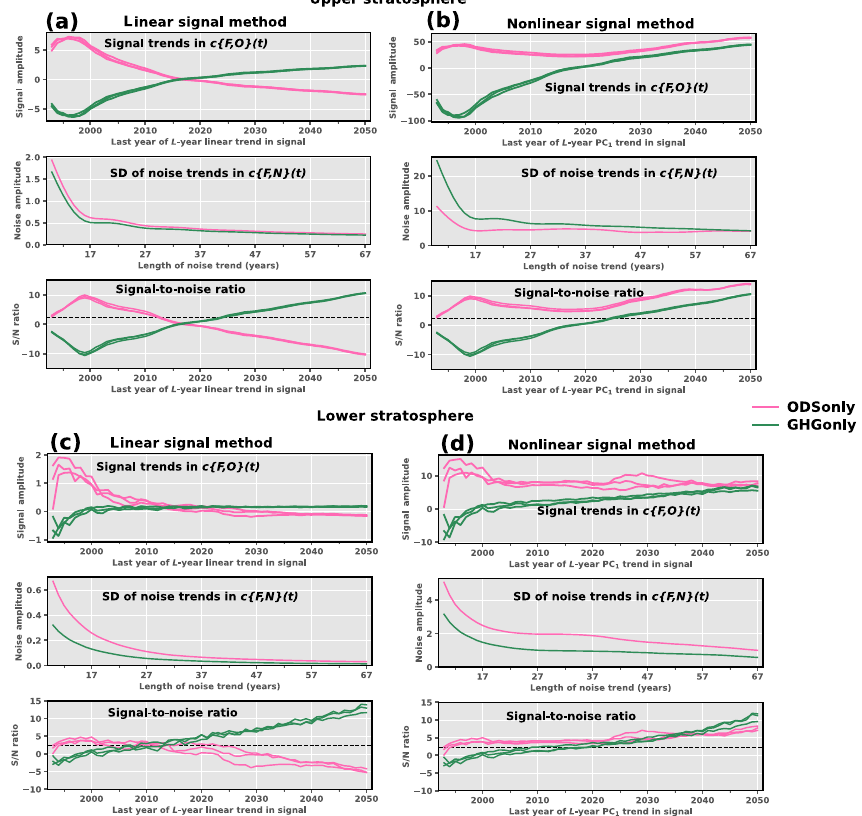
Figure 10. Same as in Figs. 7 and 8 but the ALL2 ensemble members (three total) are used as surrogate observations, yielding information regarding the estimated detection time for the ODSonly and GHGonly fingerprints in model data. The β l and β PC for the upper stratosphere (respectively); results in (c) and (d) are the corresponding method 1 and method 2 for the lower